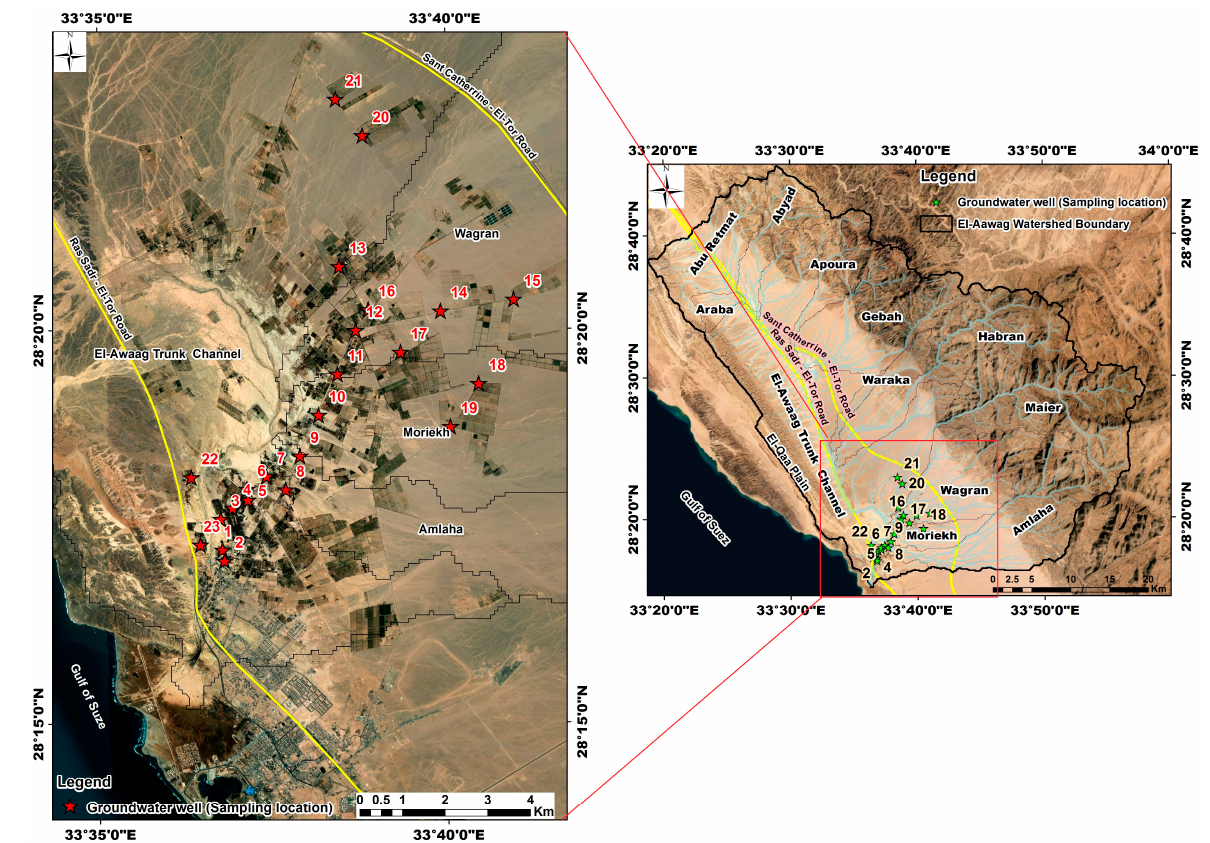
Figure 4. Location map of the collected groundwater samples.